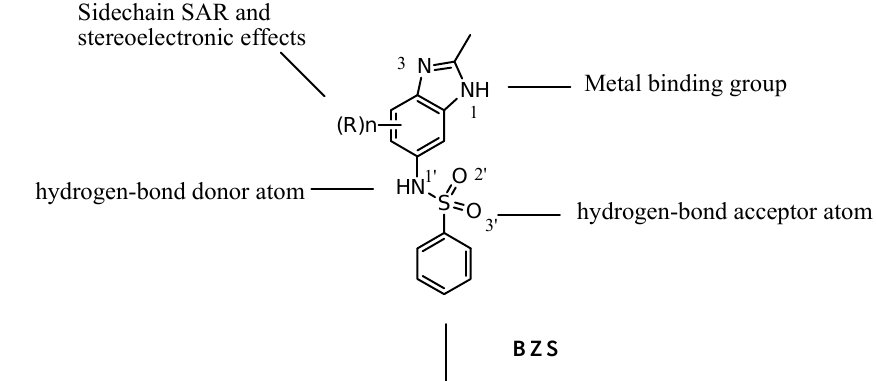
group with affinity to enzime